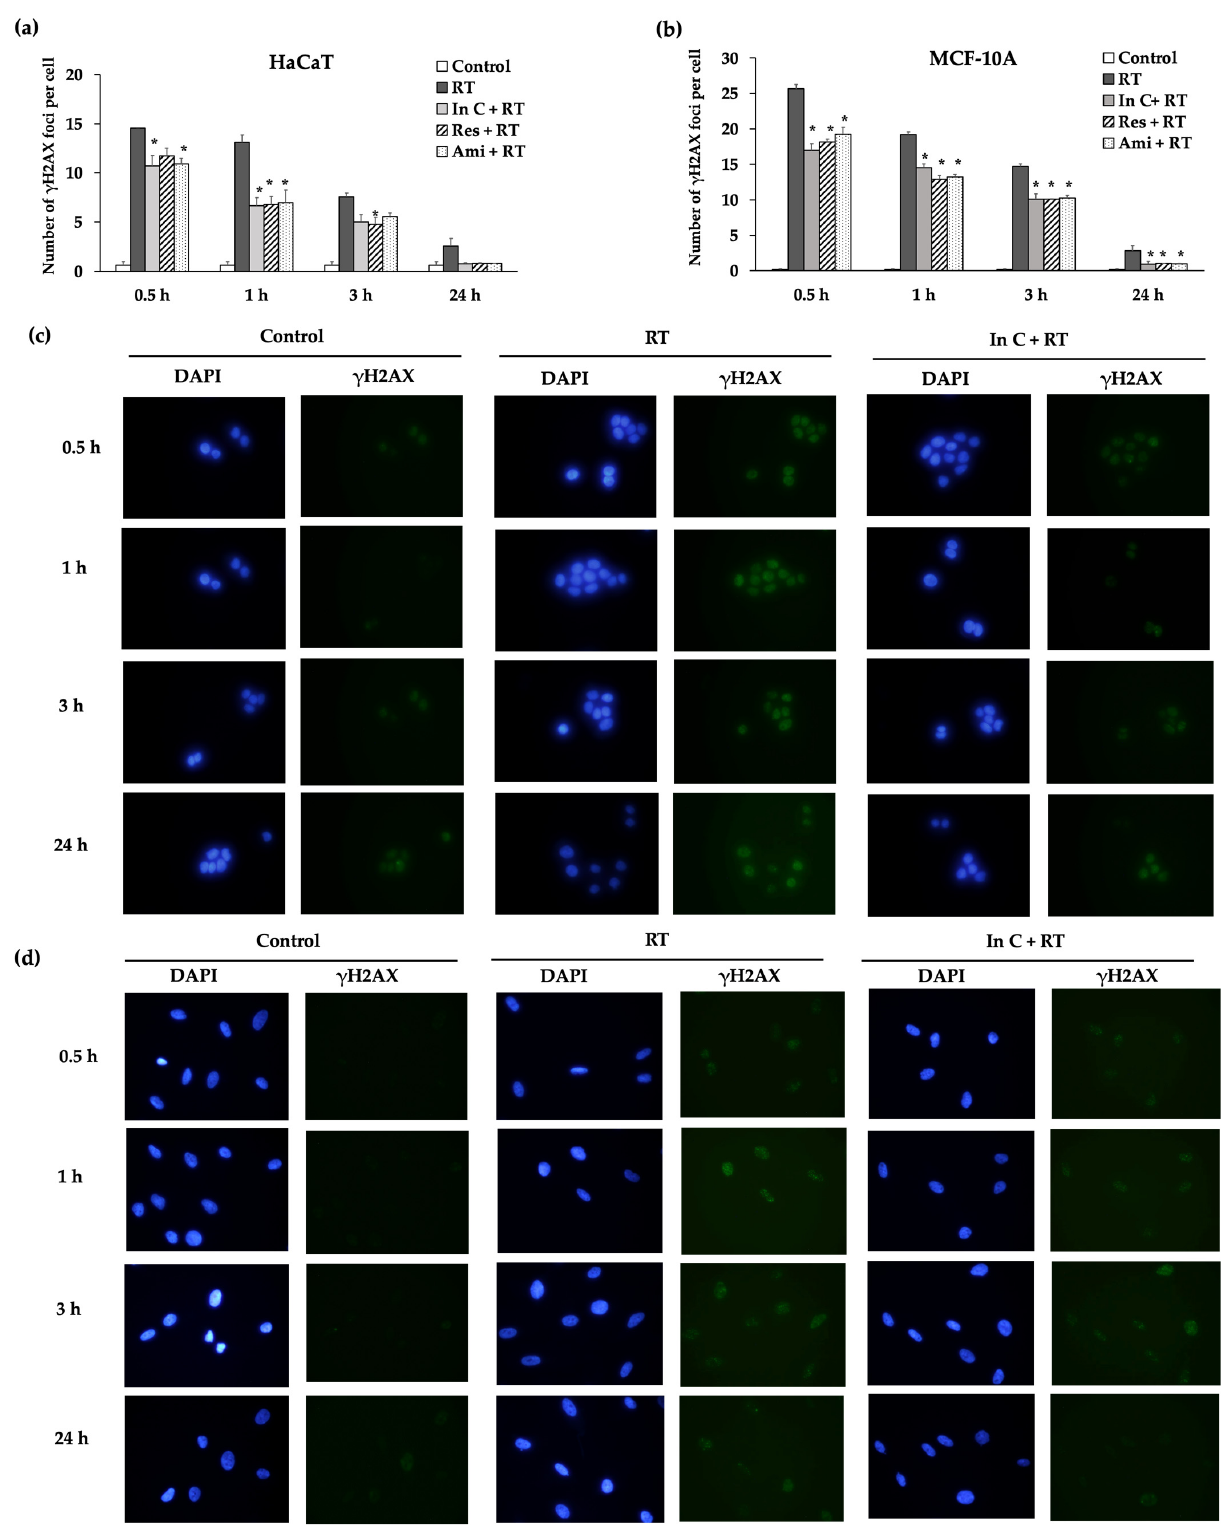
Figure 5. ( a ) γ H2AX assay to detect the number of γ H2AX foci per cell at 0.5, 1, 3, and 24 h after irradiation. The cells were pretreated with In C (interruptin C), Res (resveratrol), and Ami (amifostine) in HaCaT and ( b ) MCF-10A cell lines. The cells were nonirradiated (Control), irradiated alone (RT), and treated with interruptin C before 2-Gy cell irradiation (In C+RT). Data represent the mean